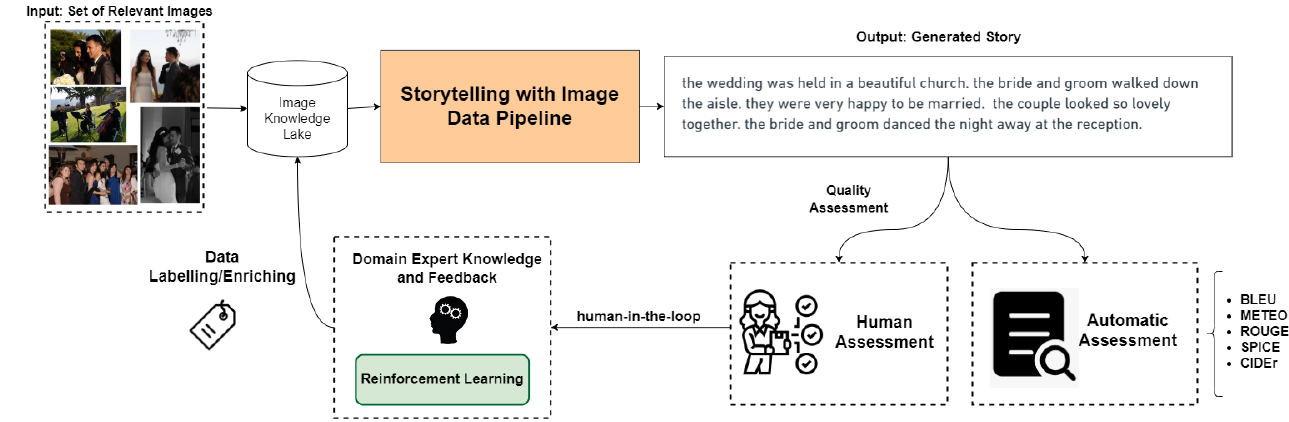
Figure 5. Quality assessment